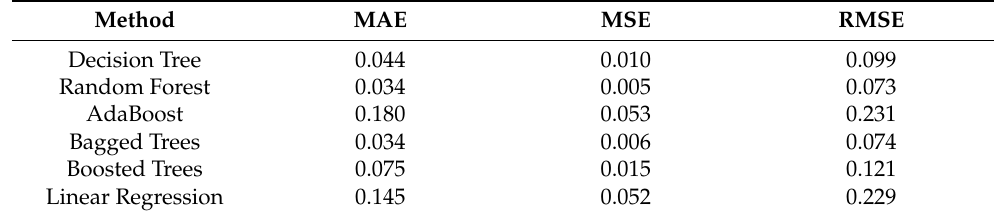
Table 5. Performance metrics for the machine learning algorithms used within the cascading